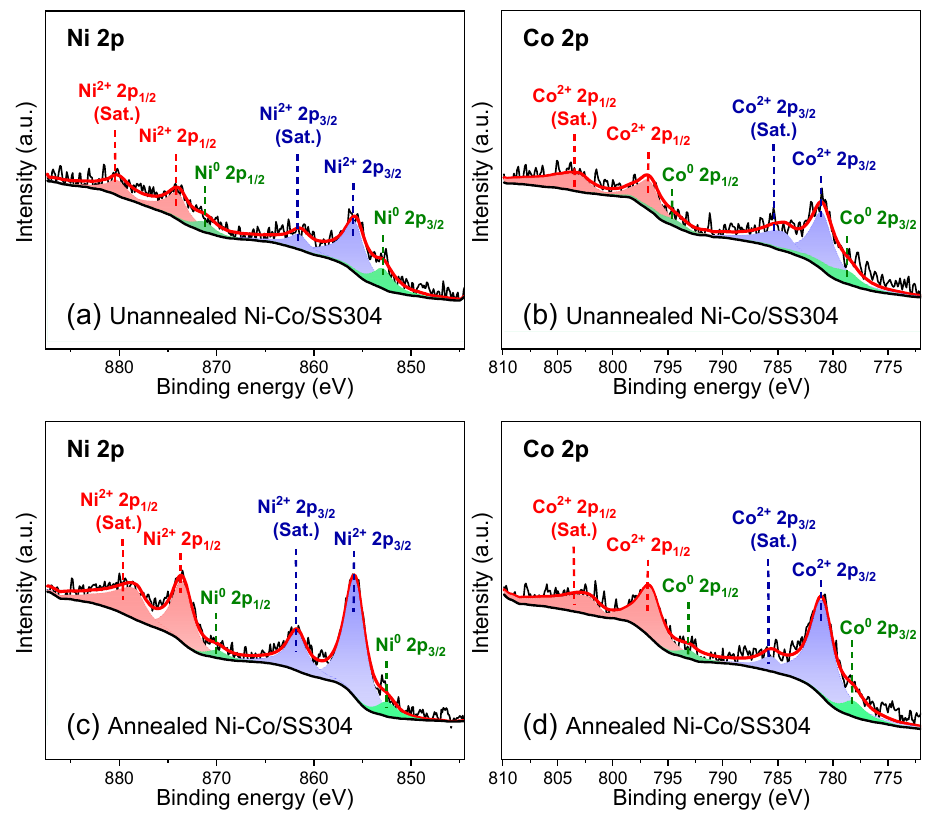
Figure 5. XPS spectra of Ni 2p and Co 2p of Ni–Co/SS304: ( a , b ) unannealed; ( c , d ) annealed.